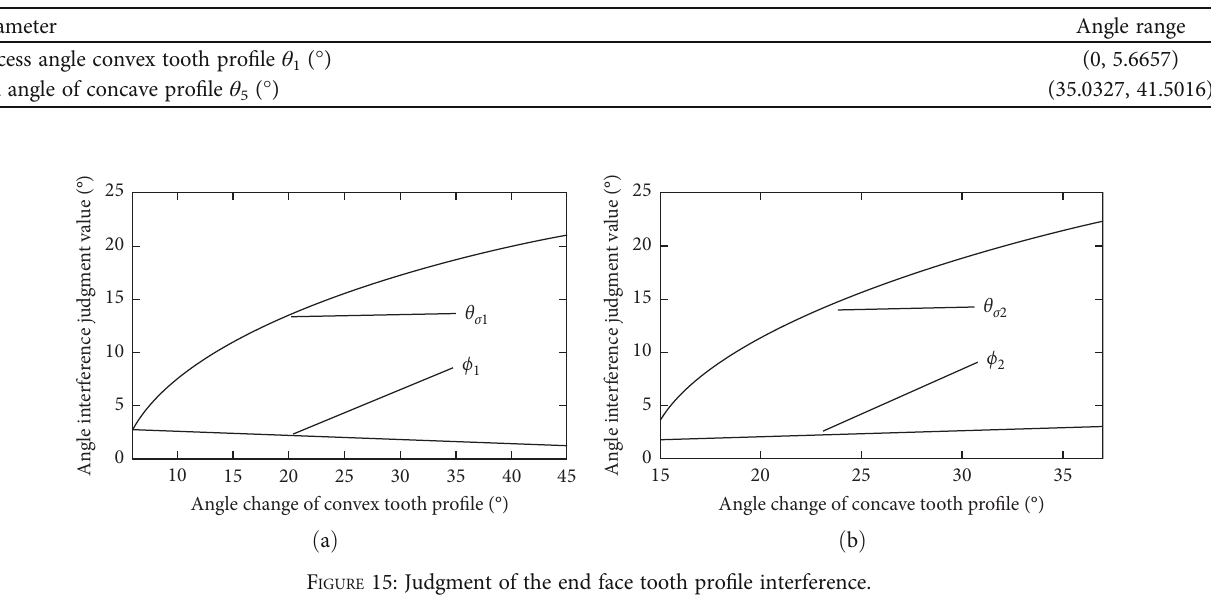
F IGURE 15: Judgment of the end face tooth pro fi le interference.